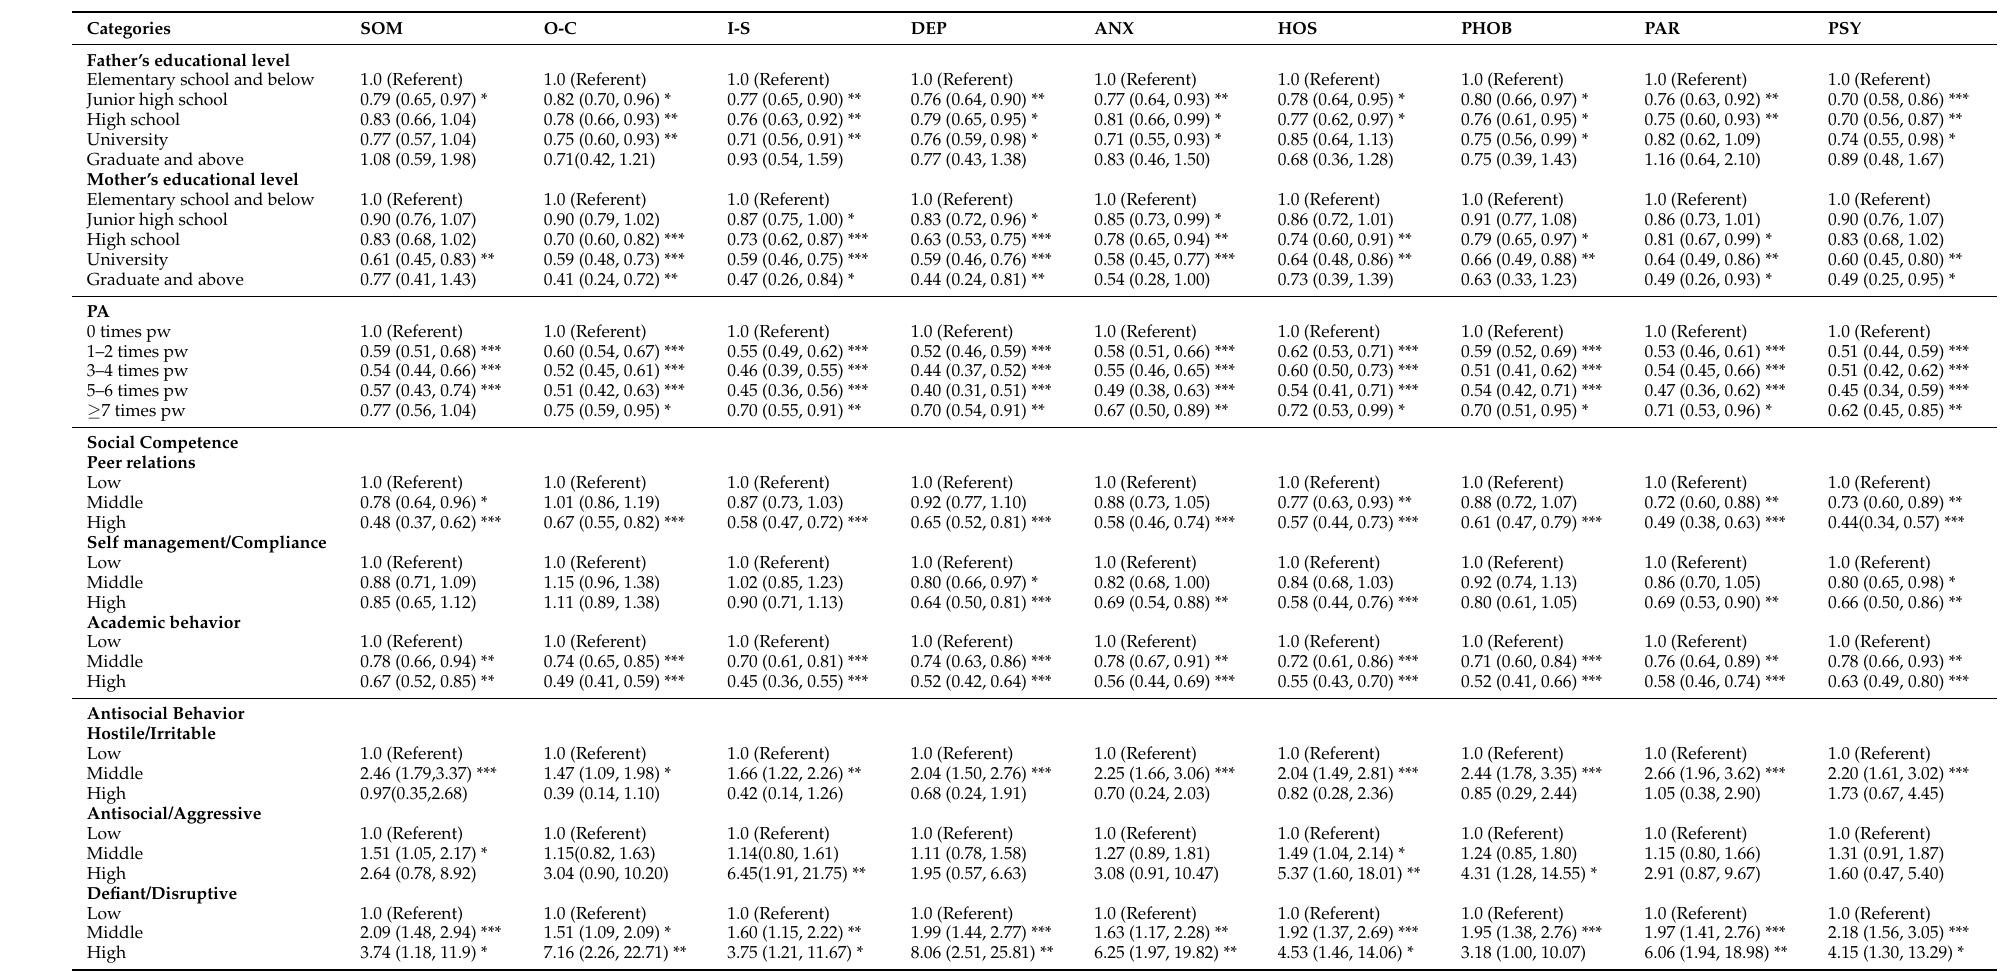
Table 4. Results of multiple logistic regression analysis on SCL-90